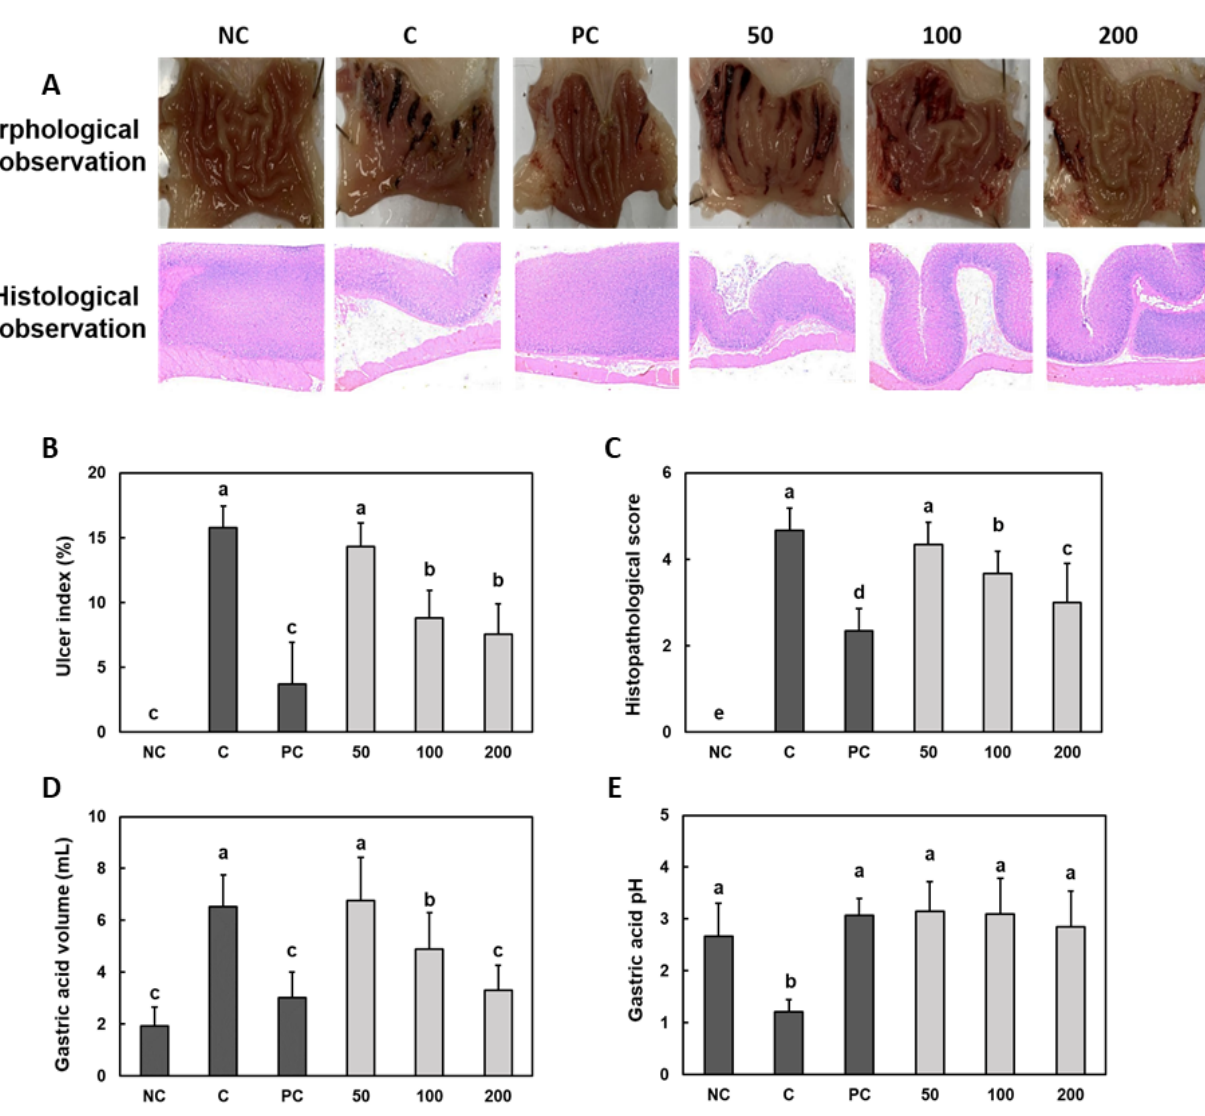
Figure 1. Effect of Gastro-AD ® on the gastric mucosal injury and gastric acid secretion induced by ethanol/HCl treatment in SD rats. ( A ) Representative images of the morphological and histological observations obtained after H&E staining in each group. The ( B ) gastric ulcer index, ( C ) histopathological score, ( D ) gastric acid volume and ( E ) gastric acid pH values. Normal control (NC; − ethanol/HCl); ethanol/HCl control (C); ethanol/HCl with 30 mg/kg b.w. of rebamipide (positive control; PC); ethanol/HCl with 50 mg/kg b.w. of Gastro-AD ® (50); ethanol/HCl with 100 mg/kg b.w. of Gastro-AD ® (100); and ethanol/HCl with 200 mg/kg b.w. of Gastro-AD ® (200). Values are presented as mean ± SD ( n = 8). Different letters indicate a significant difference, with p < 0.05, as determined using Duncan’s multiple range